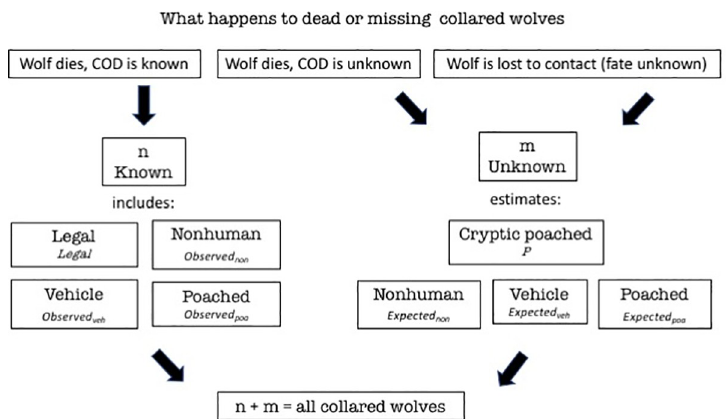
Fig 2. Unknown fates can be estimated. Observed non is the number of marked animals of known fate that died from nonhuman causes. Observed veh is the number of marked animals of known fate that died of vehicle collisions, and Observed poa is the number of marked animals of known fate that died of poaching. Expected non is the number of marked animals of unknown fate expected dead from nonhuman causes, Expected veh is the number of marked animals of unknown fate expected dead from vehicle collision and Expected poa is the number of marked animals of unknown fate expected dead from poaching. P is the estimate of marked wolves dead from cryptic poaching. To account for the possibility of cryptic poaching with transmitter destruction before the wolf meets any other fate, we allocate m to the three imperfectly reported CODs. That is why the box for cryptic poaching appears above the others on the right side of the